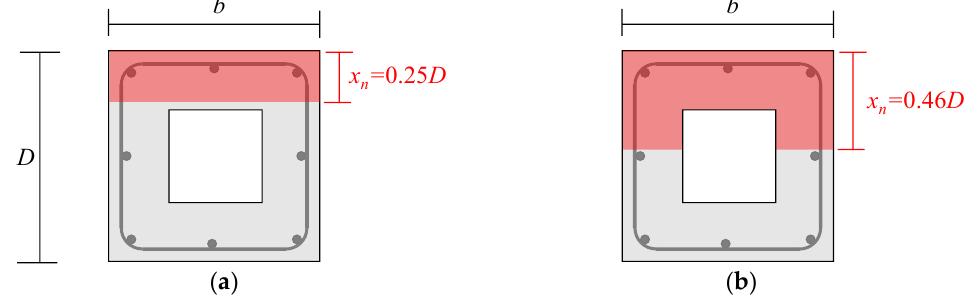
Figure 13. Neutral axis positions at ultimate flexural state by cross-sectional analysis: ( a ) CM2; ( b ) CM12 and CM13.